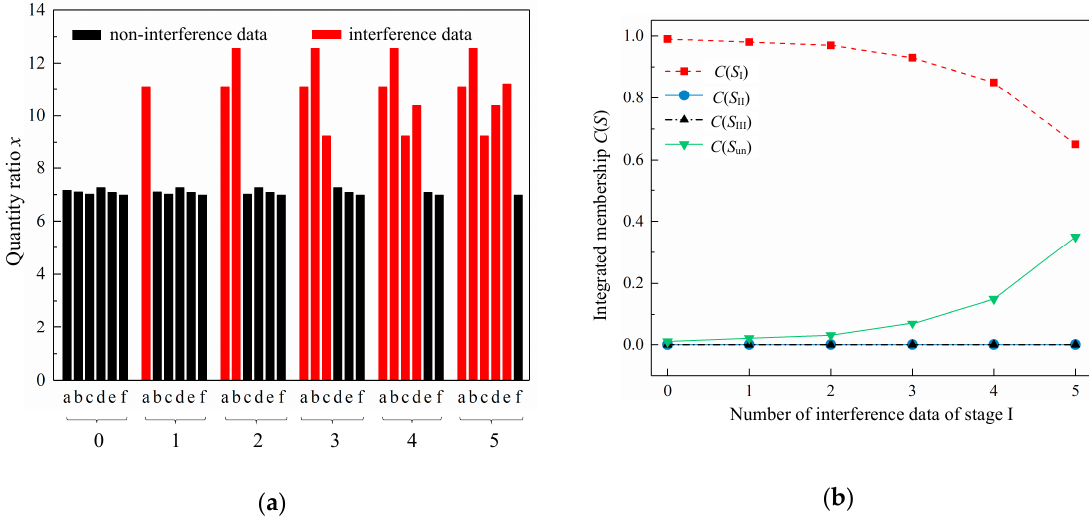
Figure 7. Performance of the model fusing di ff erent numbers of interference data of Stage I: ( a ) Quantity ratios of Methanosaeta to Methanobacterium of Stage I with di ff erent numbers of interference data (For the x-coordinate, letters a to f represent the six paralleling data, numbers 0 to 5 represent the number of interference data.) ( b ) Integrated memberships of Stage I with di ff erent numbers of interference data. (Stage I stands for the state of sludge samples after treated by centrifugal thickening and pre-dewatering, Stage II stands for the state of sludge samples after treated by thermal hydrolysis, Stage III stands for the state of sludge samples after experiencing anaerobic digestion, and stage uncertain stands for the uncertainty of the processing stage a ffi liation of a sludge sample.)